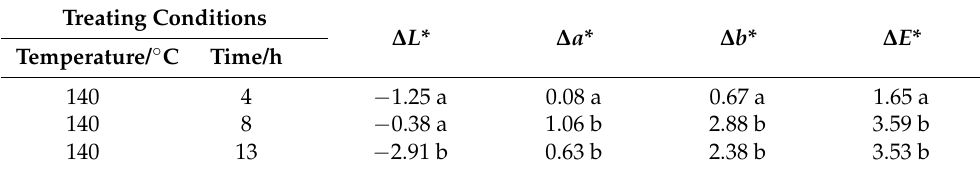
Table 2. Color parameters of wood before and after heat treatment.